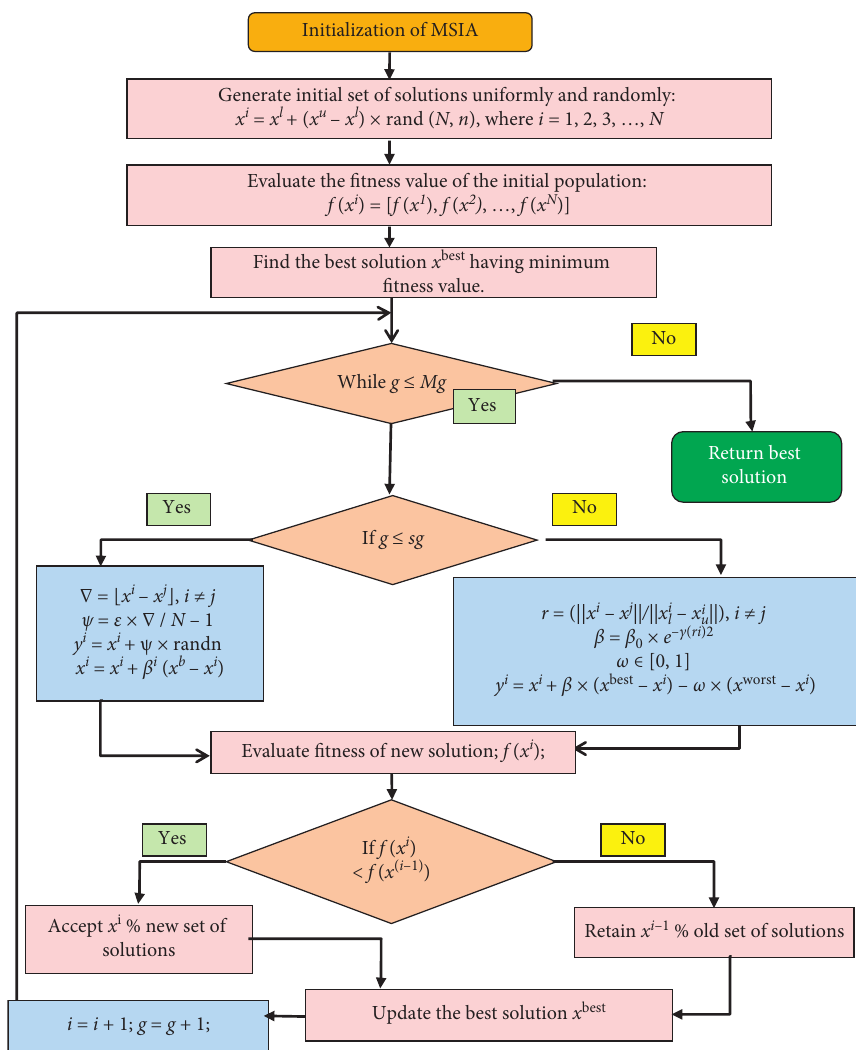
Figure 2: Flowchart of the proposed multiswarm-intelligence-based algorithm